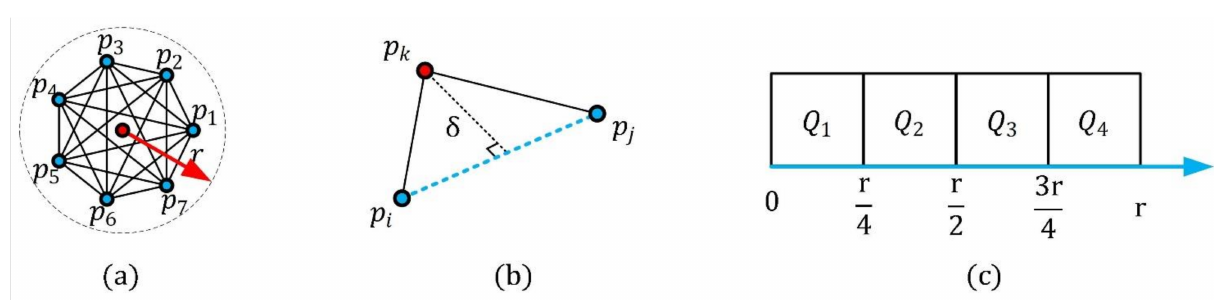
Figure 1. Partition of the point-pair sets. ( a ) All point-pairs in the key point neighborhood. ( b ) The partition feature δ of the (cid:16) (cid:17) p i , p j point-pair . ( c ) The four point-pair subsets based on the feature δ